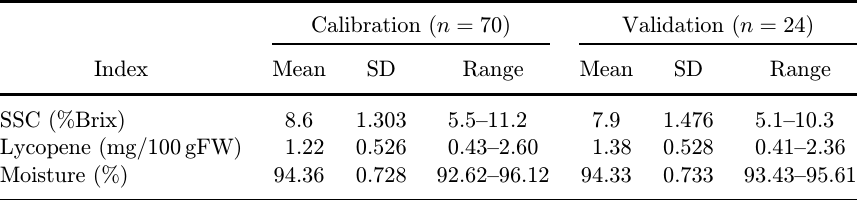
Table 3. Statistics of chemical parameters of watermelon samples in calibration and prediction sets, respectively.